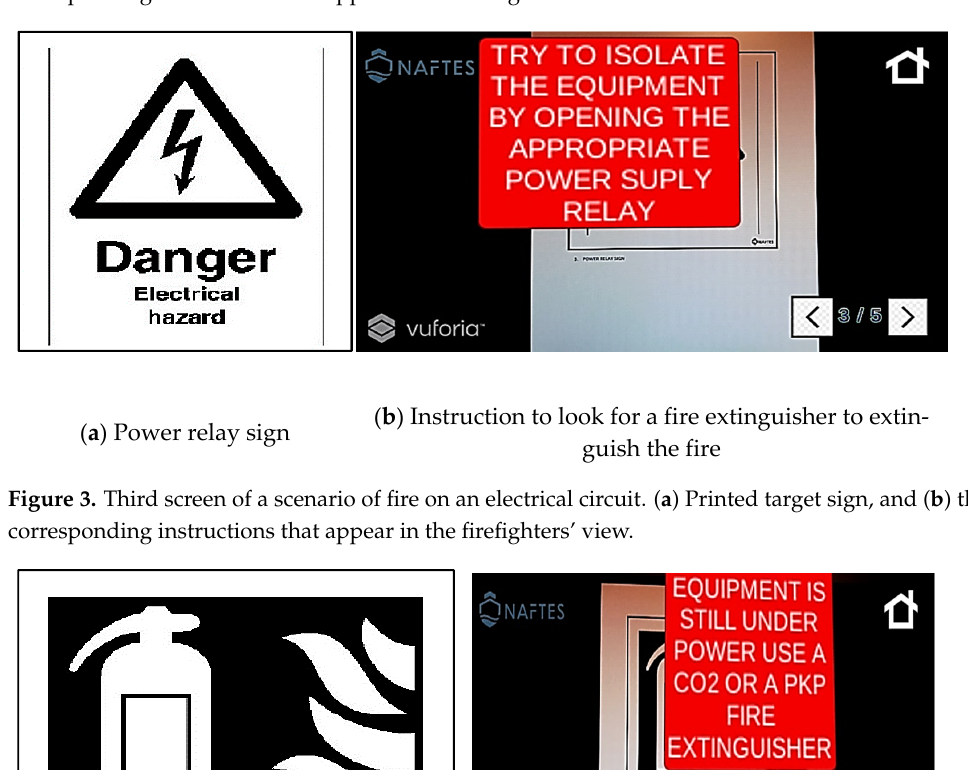
Figure 3. Third screen of a scenario of fire on an electrical circuit. ( a ) Printed target sign, and ( b ) the corresponding in- structions that appear in the firefighters’ view.